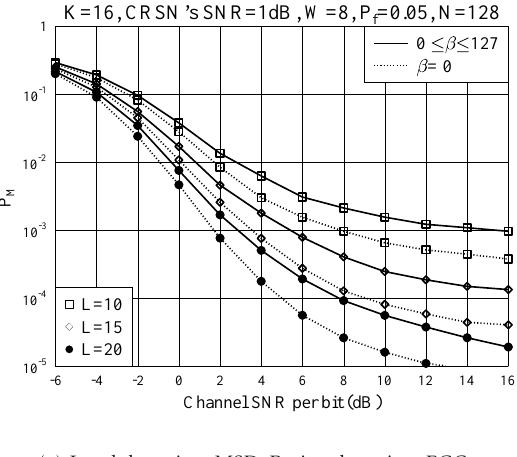
Figure 10. Missing probability of the MSD-assisted CRSNs sensing an IFDMA system using 128 subcarriers for supporting maximum 16 users, when four sensing scenarios are considered.